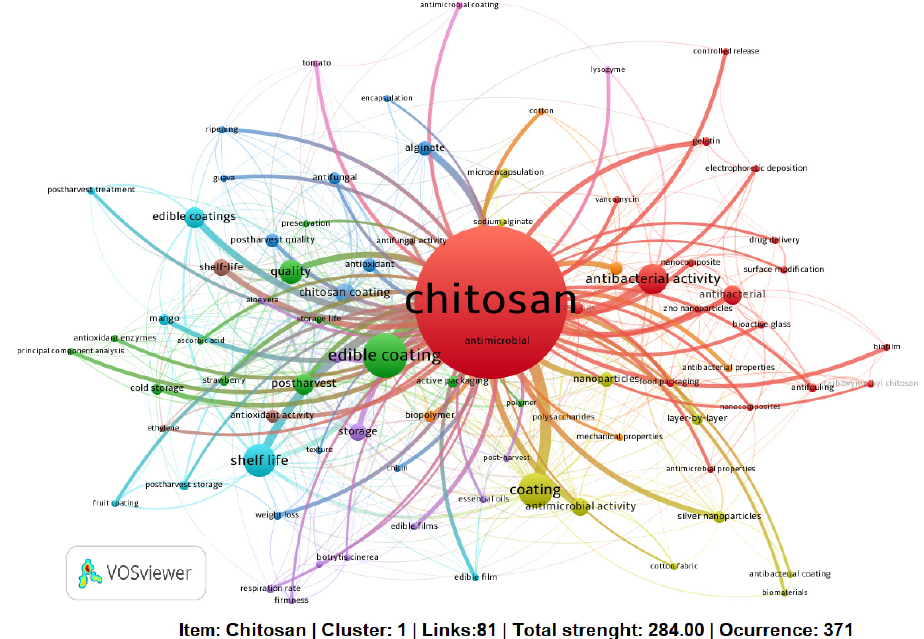
Figure 3. Map of co-occurrence network visualization based on article weights for the terms related with the first group.